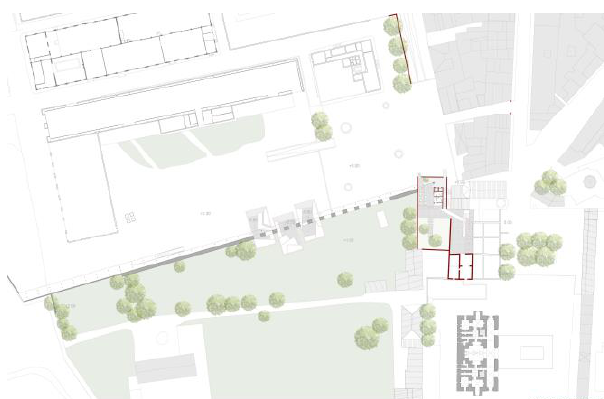
Figure 13. New relations between Zisa site and ‘Cantieri culturali’ area (Sferrazza, 2015)